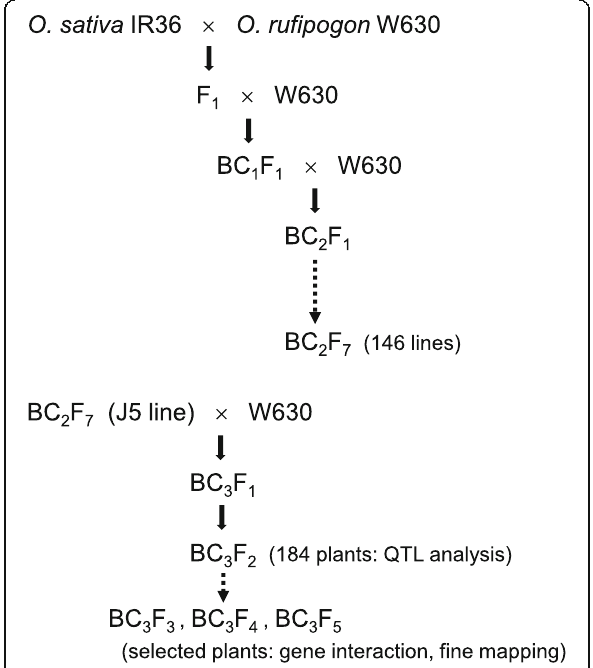
Fig. 2 Pedigree of backcross recombinant inbred lines between O. sativa IR36 and O. rufipogon W630. A single line of J5 was further backcrossed with W630, and their BC 3 progenies were used for the genetic